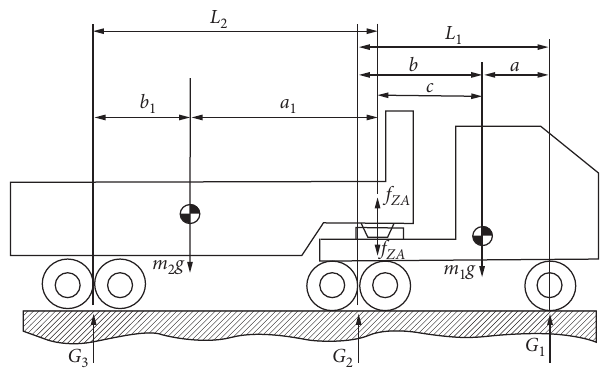
Figure 7: Schematic showing the load calculation and handling and stability as compared with the real vehicle test data.